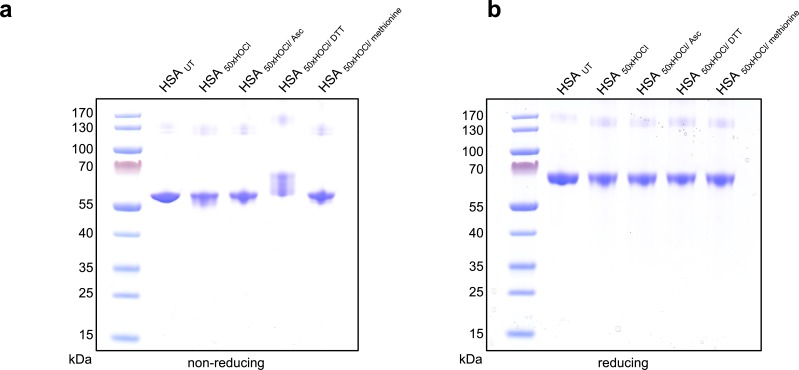
Influence of reducing agents on the migration of HSA on reducing and non-reducing SDS PAGE gels.(a) Untreated HSA and HSA treated with a 50-fold molar excess of HOCl and subsequently reduced with various reductants separated on a non-reducing gel. HOCl-treatment does not lead to accumulation of a disulfide linked dimer that could potentially form by oxidation of the single free cysteine in HSA. DTT-treatment leads to a change in the migration of HSA, presumably by reducing HSA’s many intramolecular disulfide bonds. Neither ascorbate nor methionine induce a change in migration. (b) On a reducing gel (containing β-mercaptoethanol in the loading buffer) all samples migrate to the same, compared to the non-reducing gel, higher position.
10.7554/eLife.47395.010Figure 2—figure supplement 3—source data 1.Original scans of gels represented in Figure 2—figure supplement 3.